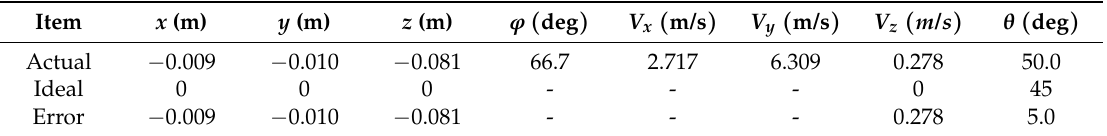
Table 3. The terminal state of the helicopter and the ideal state.